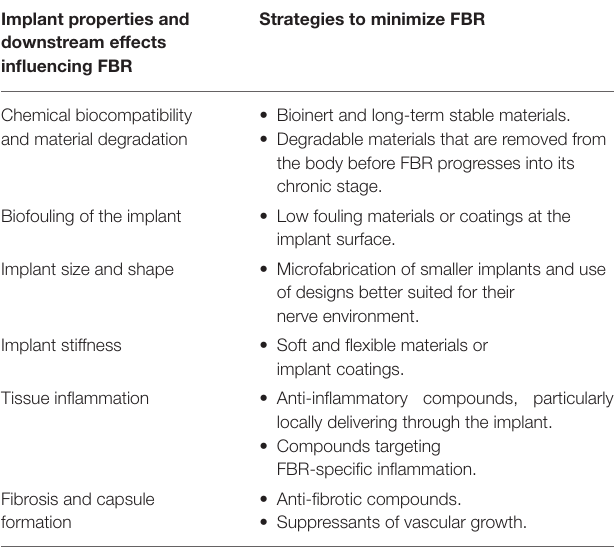
TABLE 2 | Summary of factors influencing FBR to implants and strategies employed to minimize it. Implant properties and downstream